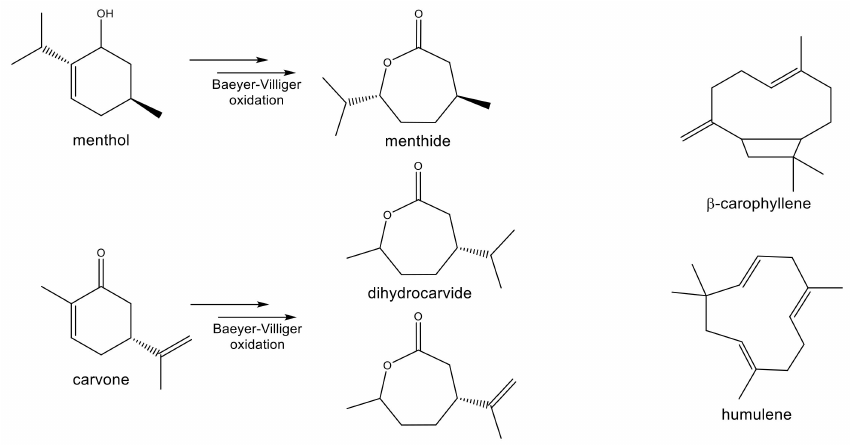
Figure 4. Synthesis and structure of some polymerizable cyclic